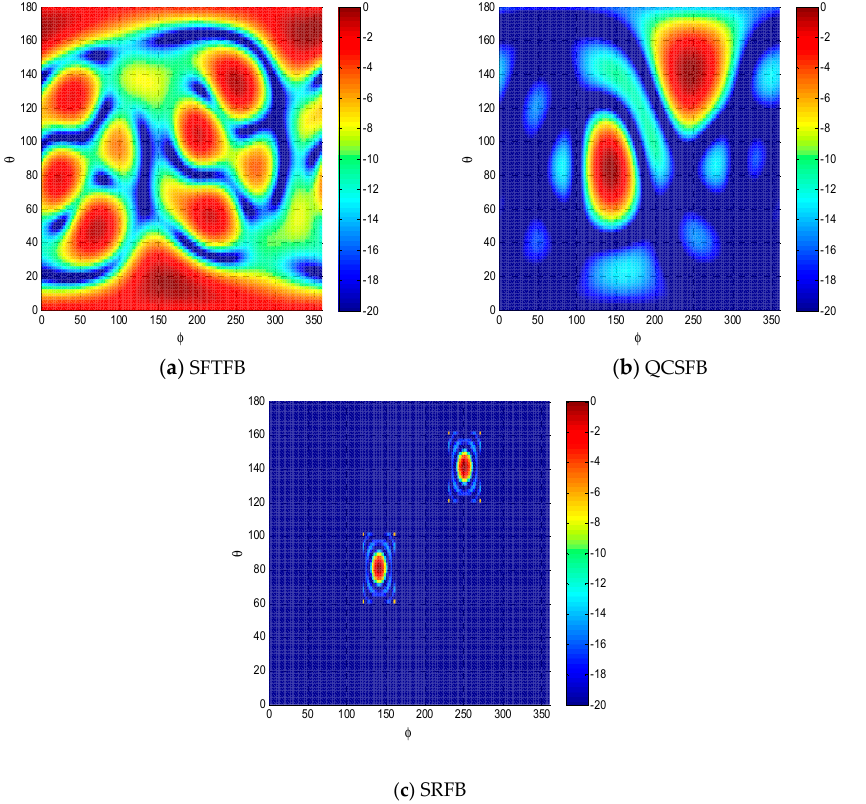
Figure 3. Sound sources localization simulation results for the ( a ) SFTFB, ( b ) QCSFB and ( c ) spherical reverse focused beamforming (SRFB) methods.